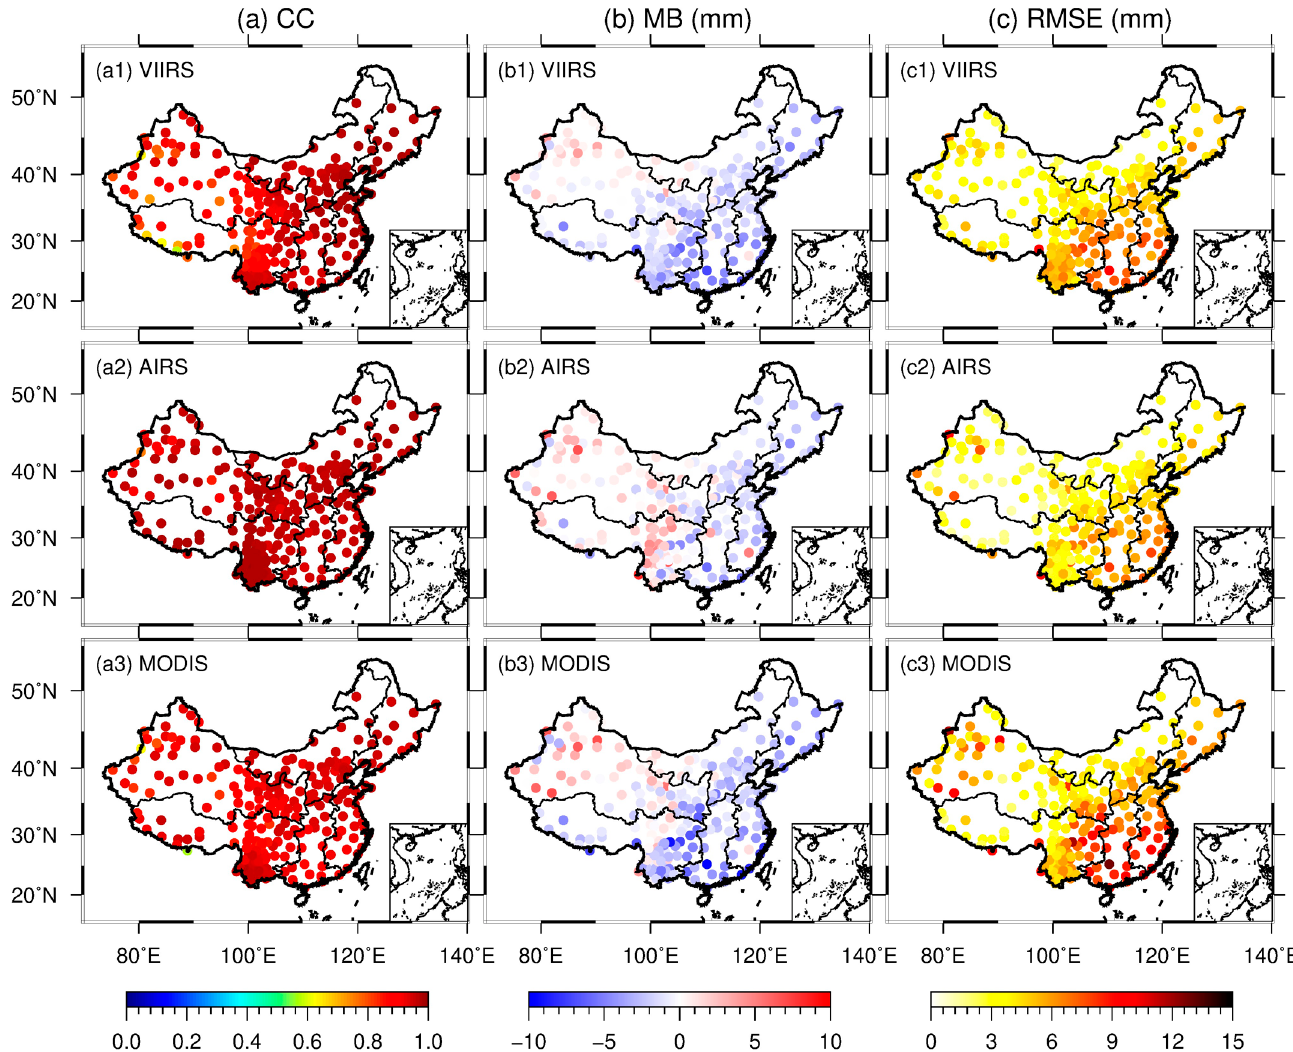
Figure 7. Three evaluation metrics (i.e., the CC ( a ), MB ( b ), and RMSE ( c )) of the PWV data derived from the remotely sensed water vapor products compared with the GPS-PWV at each GNSS station in mainland China.